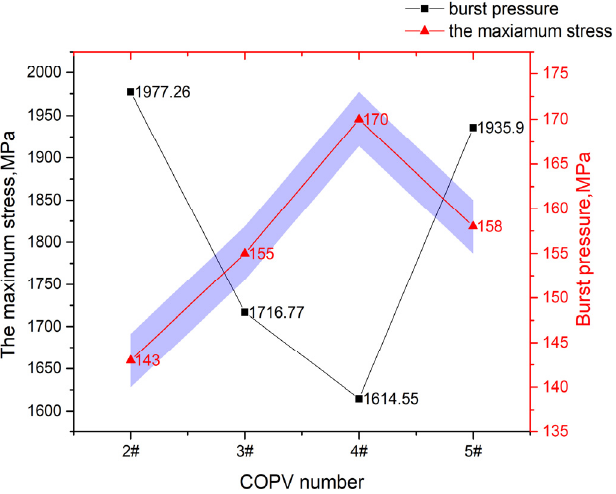
Figure 8. Maximum Stress Value and Burst Pressure of COPV( purple area: margin of error).